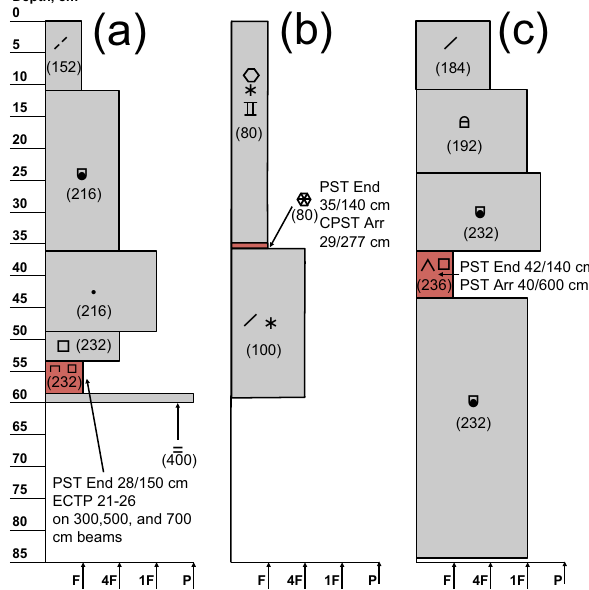
Figure 8. (a–c) Profiles for FE simulation. Profiles for each of the finite element simulations. Depth is from the snow surface, hand hardness is on the horizontal axis, and layer densities (kgm − 3 ) are in parenthesis. The weak layer is red. The symbols for snow crystal types are from the “International Classification for Seasonal Snow on the Ground” (Fierz et al.,